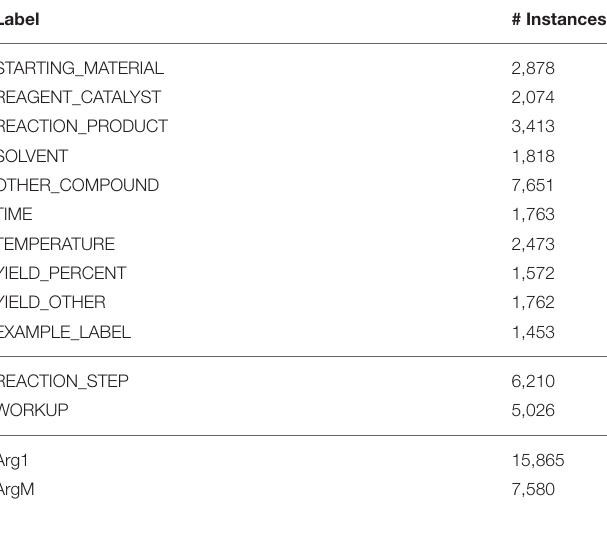
TABLE 4 | Number of instances for each label defined in Table 2 .